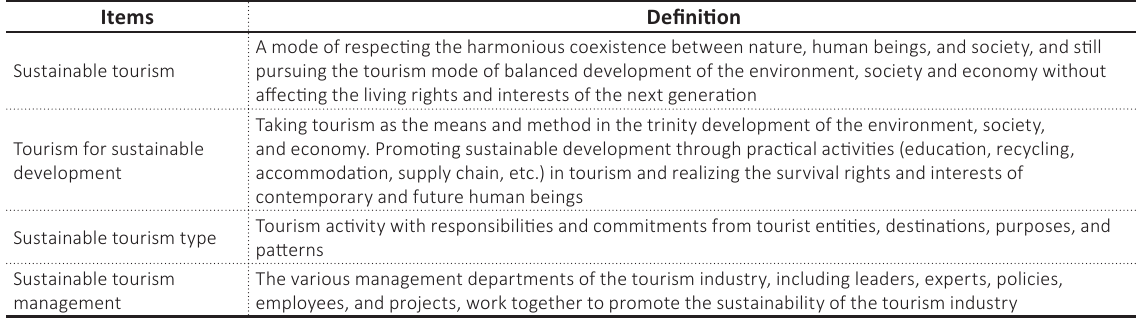
Figure 5. Tree-map of hierarchy analysis for sustainable tourism Table 5. The relevant definition of sustainable tourism from the perspective of social